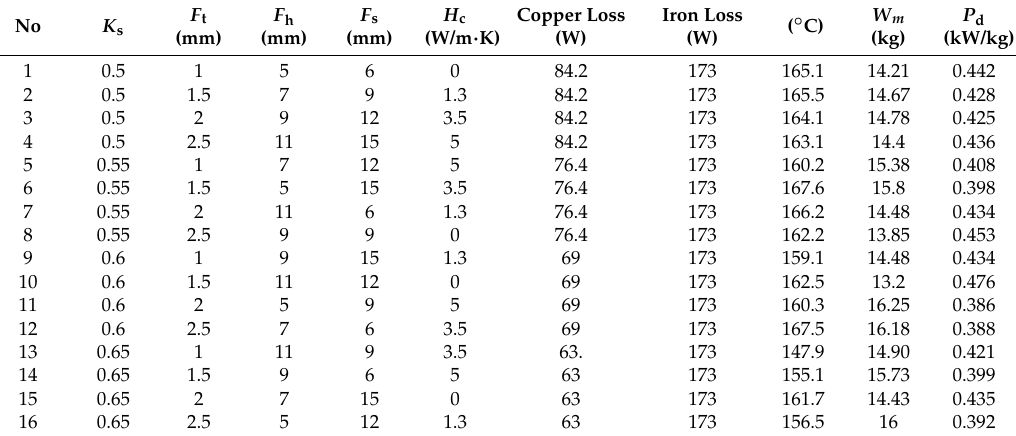
Table 8. Experimental arrays and results of thermal network